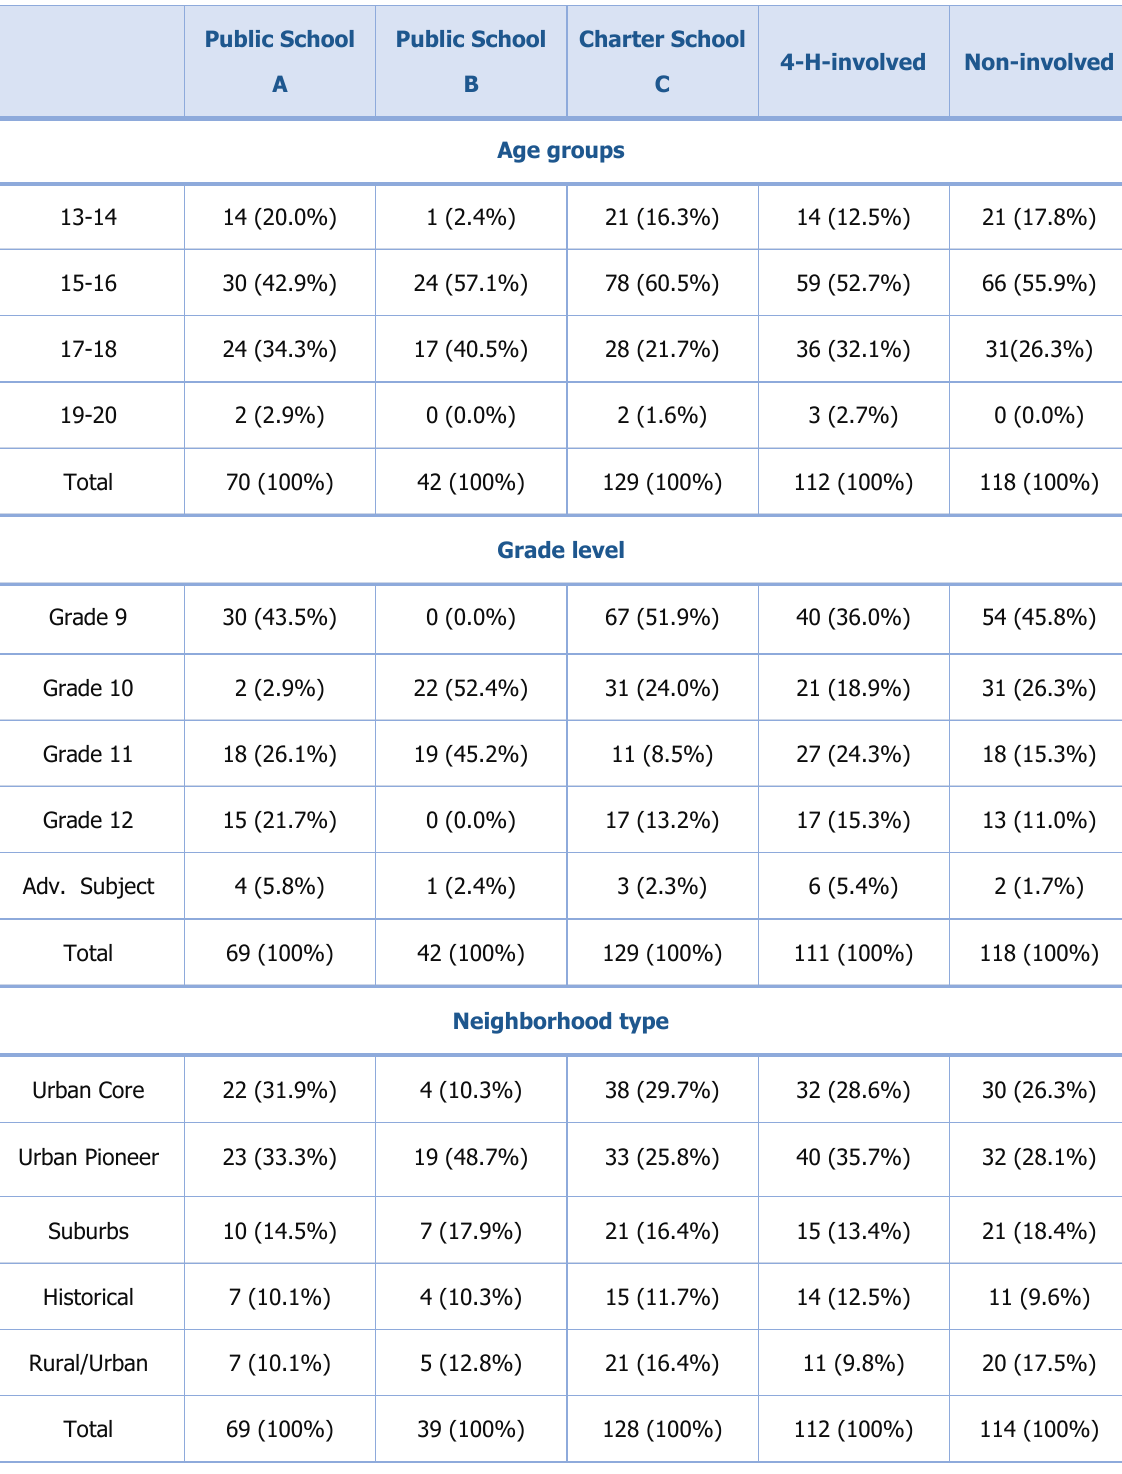
Table 1. Demographic Characteristics of Sample